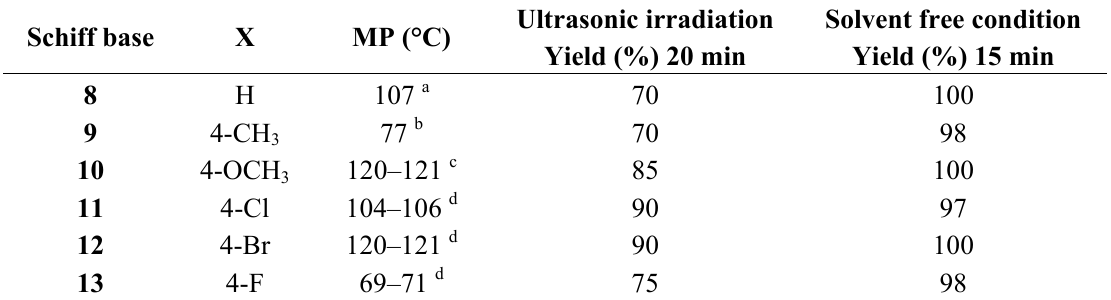
Table 1. Yields and melting points of the Schiff bases ( 8 – 13 ) obtained in solvent free conditions and under ultrasonic